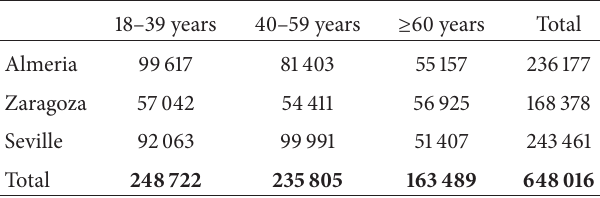
Table 1: Distribution of inhabitants by region and